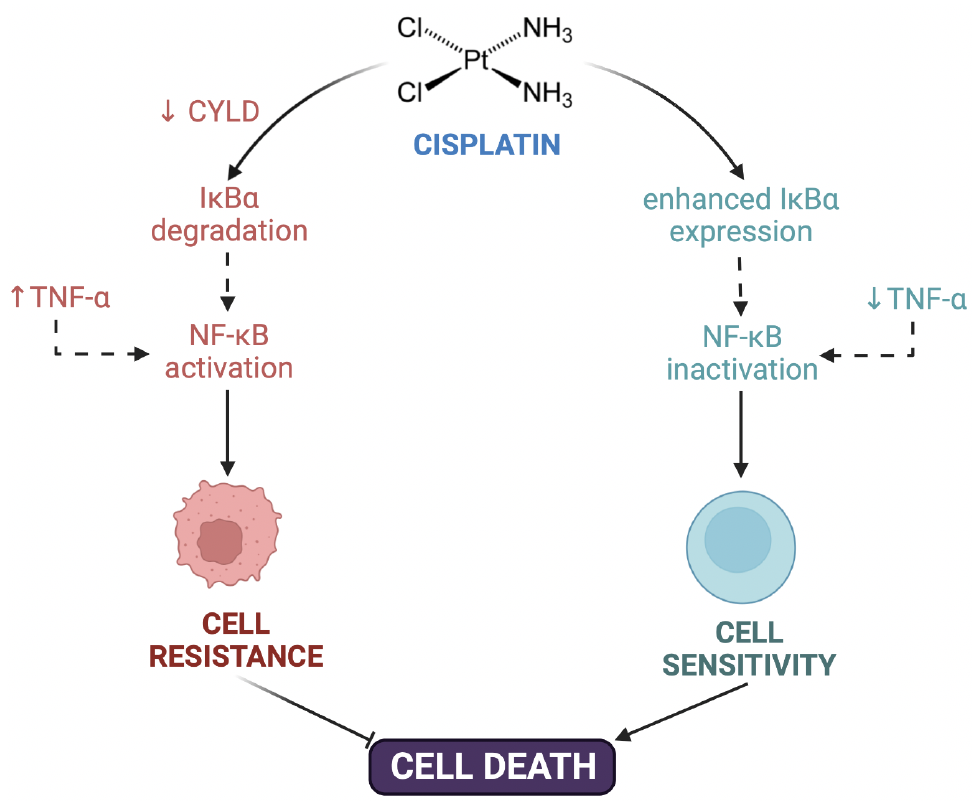
Figure 1. Contribution of NF- κΒ to cisplatin resistance. Cisplatin resistance is caused by downregulation of CYLD lysine 63 deubiquitinase (CYLD), triggering the suppression of cell death via NF- κ B hyperactivation. TNF- α also contributed to NF- κ B activation and cell resistance. Created with Biorender.com.